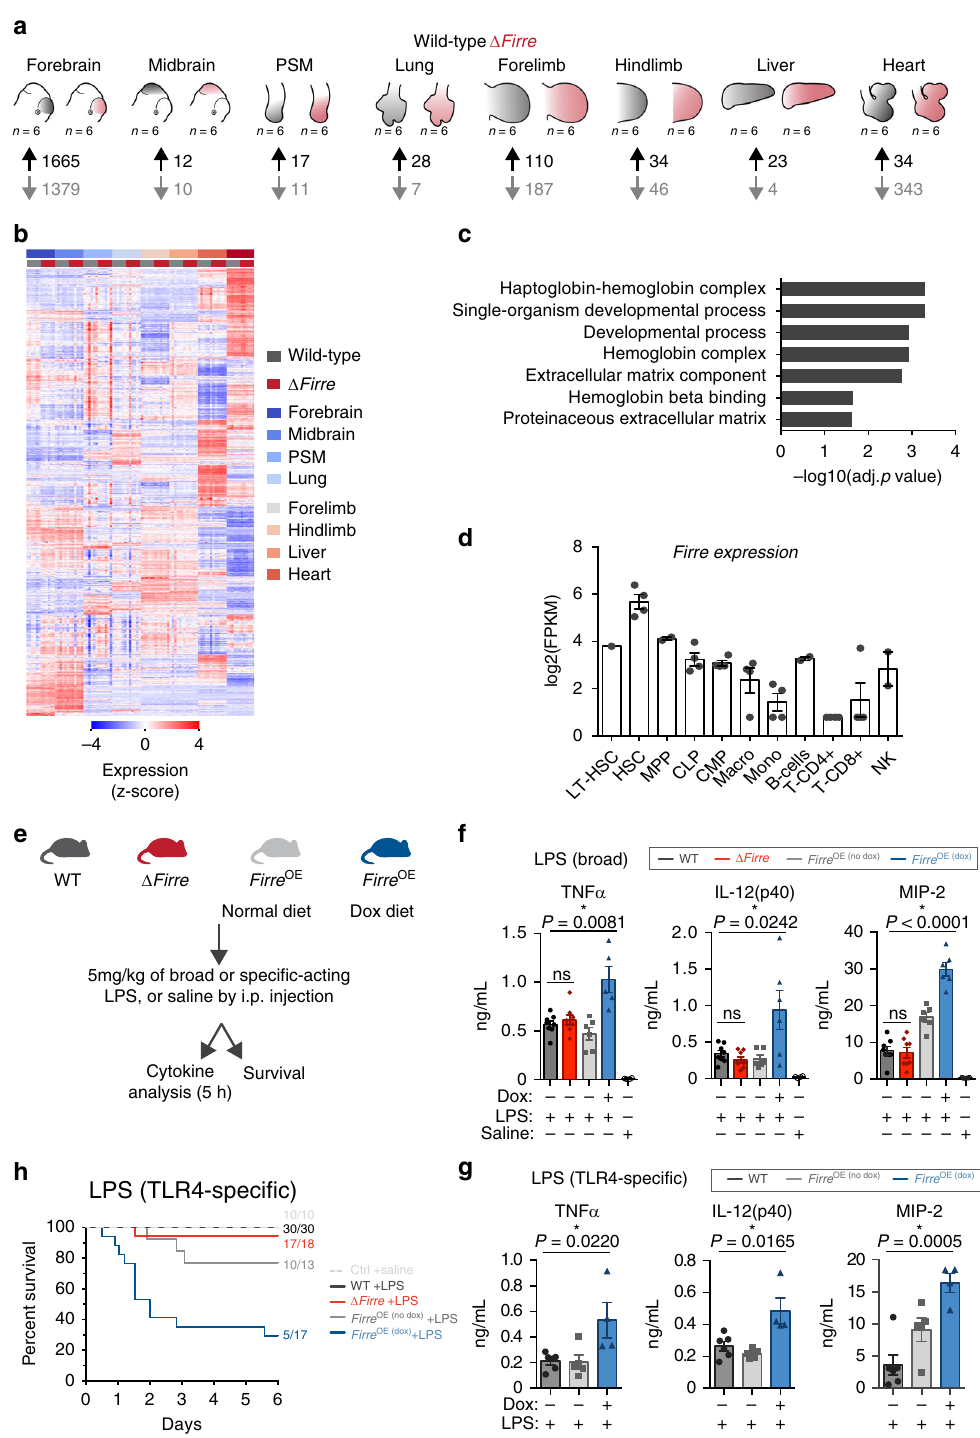
Fig. 2 Modulation of Firre impacts genes with roles in the blood. a Schematized E11.5 tissues used for RNA-seq. WT ( n = 6) shown in black, and Δ Firre ( n = 6) shown in red. The number of differentially expressed genes shown below each tissue. b Heatmap of replicate embryonic tissues. c GO analysis for genes found dysregulated in four or more tissues. d Firre expression across multiple mouse blood cell lineages (RNA-seq data from bloodspot.eu, GSE60101). e Experimental approach for cytokine and survival experiments. f Cytokine measurements in serum at 5 h post intraperitoneal (i.p.) injection